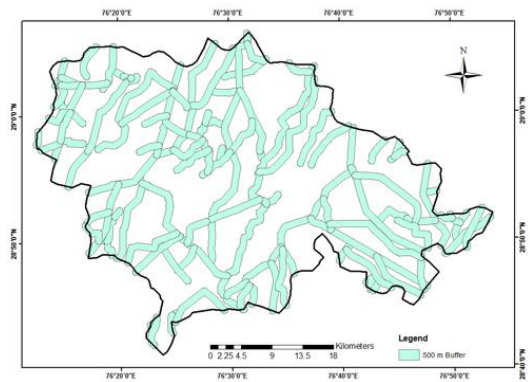
Fig 11: Surface waterlogged areas map (March, 2017)